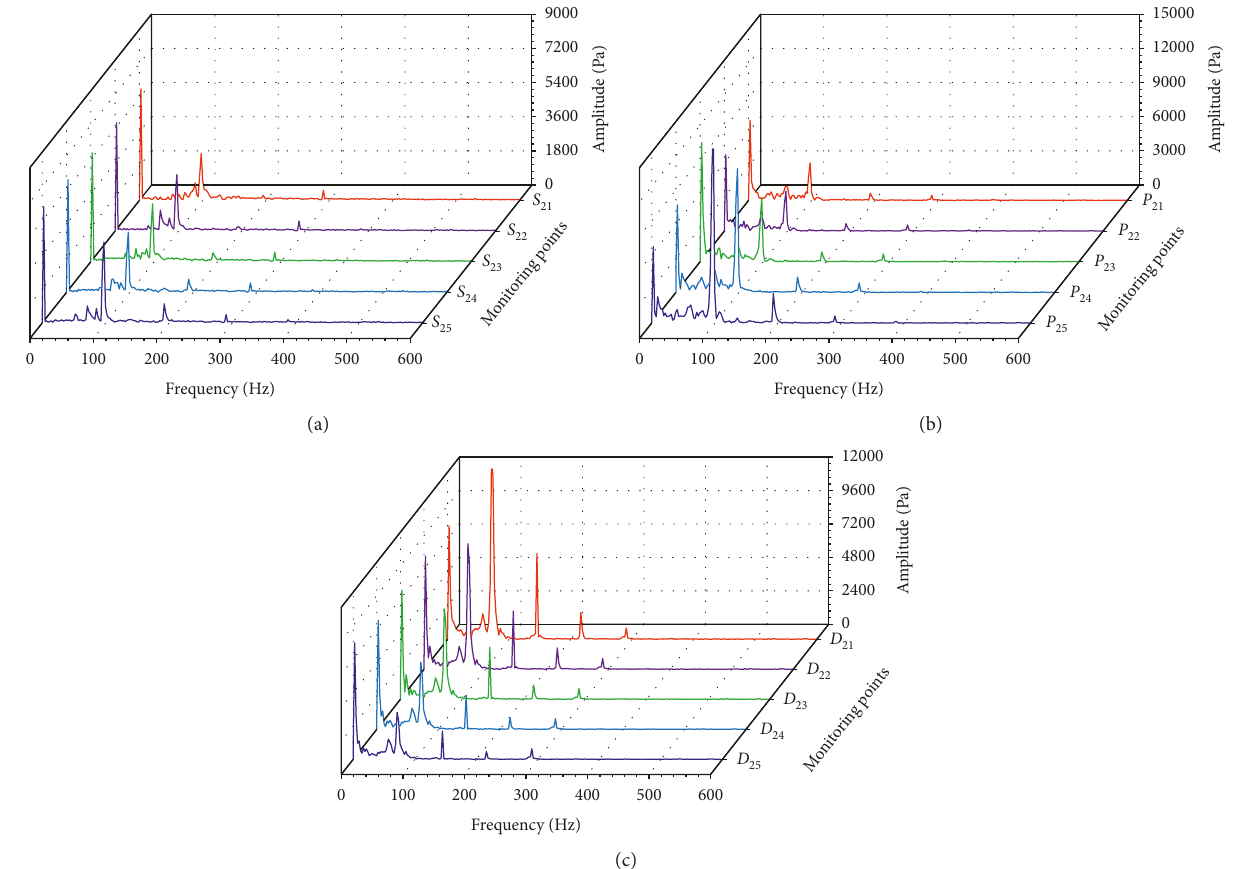
Figure 12: Pressure pulsation in the frequency domain at monitoring points during the second stage: (a) impeller blade suction side, (b) impeller blade pressure side, and (c)